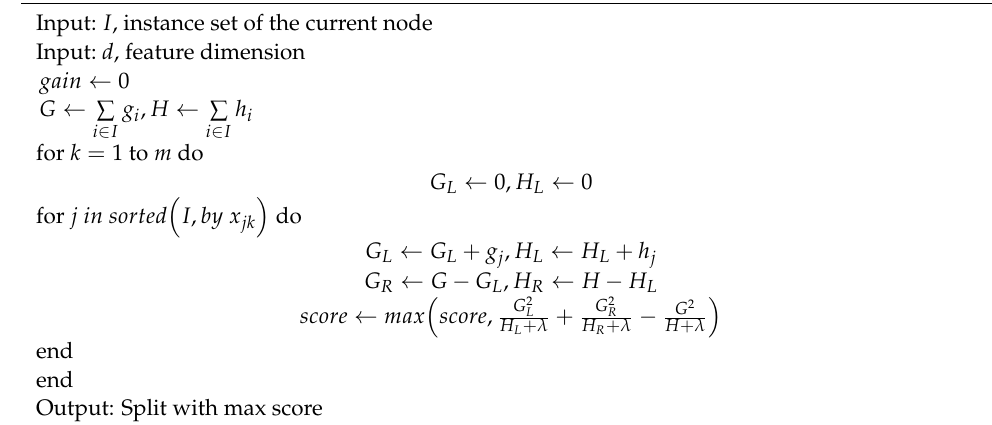
Algorithm 1: Exact Greedy Algorithm for Split Finding.